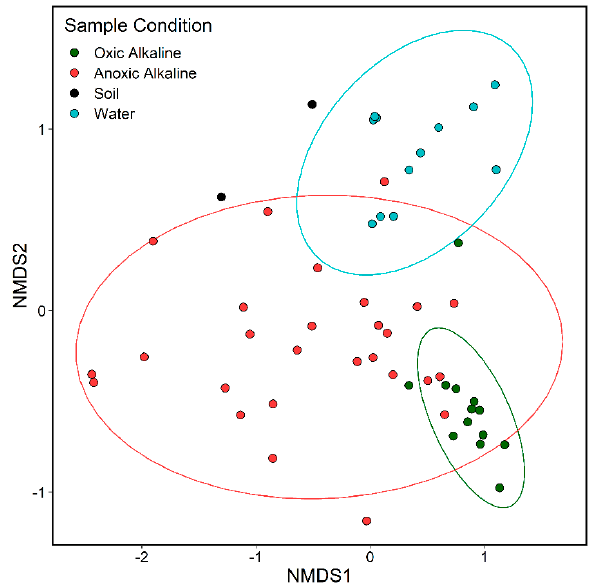
Figure 6. Non-Metric Multi-Dimensional Scaling plot of Calumet sites using Bray-Curtis distance, grouped by physical conditions of samples. “Oxic Alkaline” corresponds to the Horizontal Bank / Waterline samples, “Anoxic Alkaline” corresponds to Horizontal Sediment and all Vertical transect samples. Ellipses represent 95% confidence intervals for the NMDS coordinates.